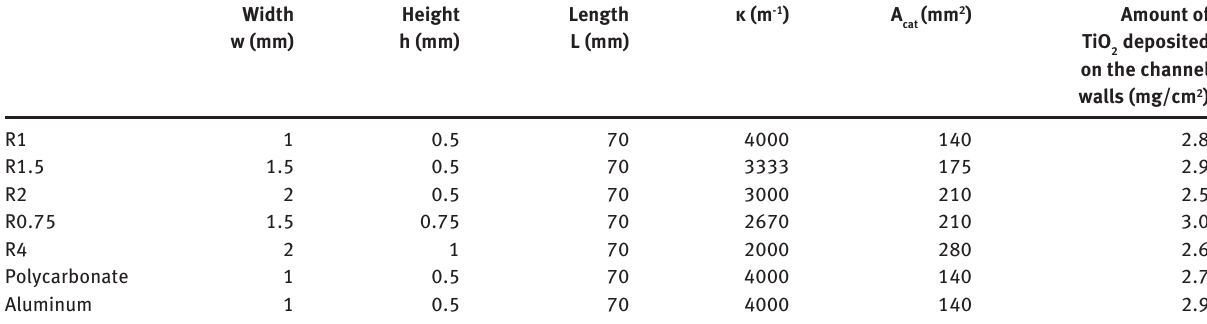
Table 1 Geometrical characteristics of the rectangular polymeric ( “ R ” ), aluminum ( “ Aluminum ” ), and polycarbonate ( “ Polycarbonate ” ) microchannel